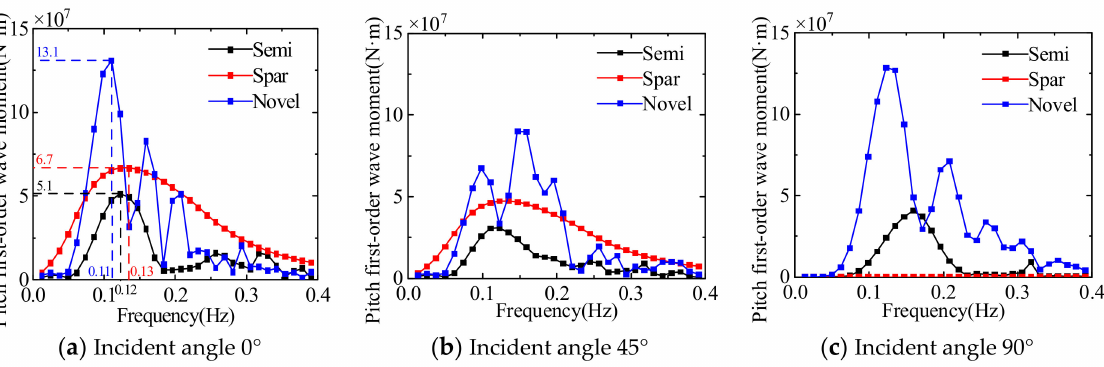
Figure 15. Comparison of the first-order wave moment in the pitch direction of three floating platforms.